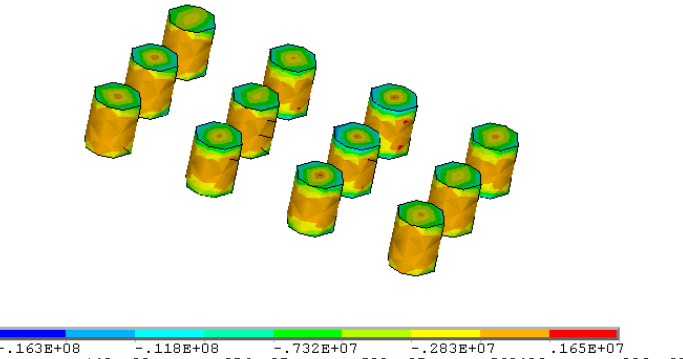
Figure 35. Maximum principal stress distribution of scheme 9 pillars at 1480 mL (parameters of